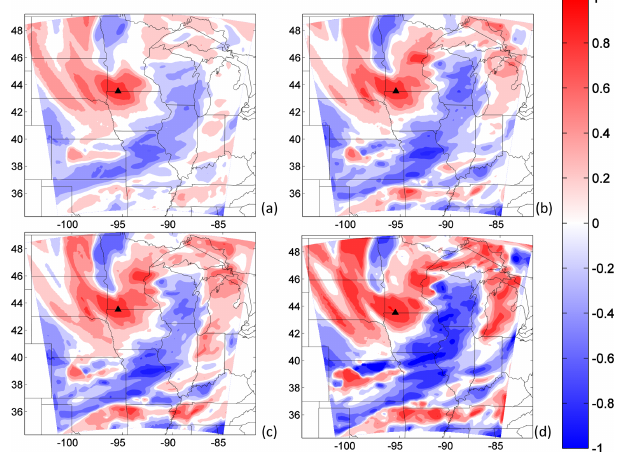
Figure 15. Spatial correlation of CO 2 for the 45- (a) , 10- (b) , 8- (c) and 5-member (d) ensembles with respect to the location of the Round Lake tower for DOY 180. This figure uses the calibrated ensembles of 10, 8 and 5 members found by the SA